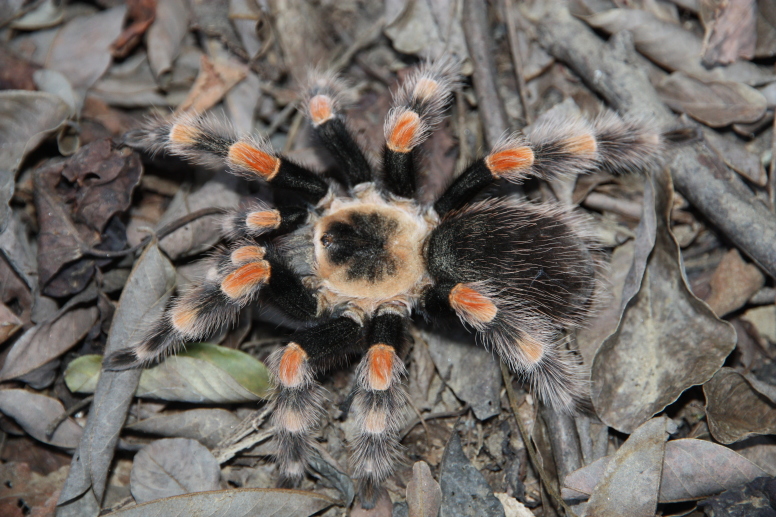
Brachypelma
smithi (F. O. P.-Cambridge, 1897) female of morphotype at type locality from Dos Arroyos, Guerrero state, Mexico. Photo: Stuart J. Longhorn.